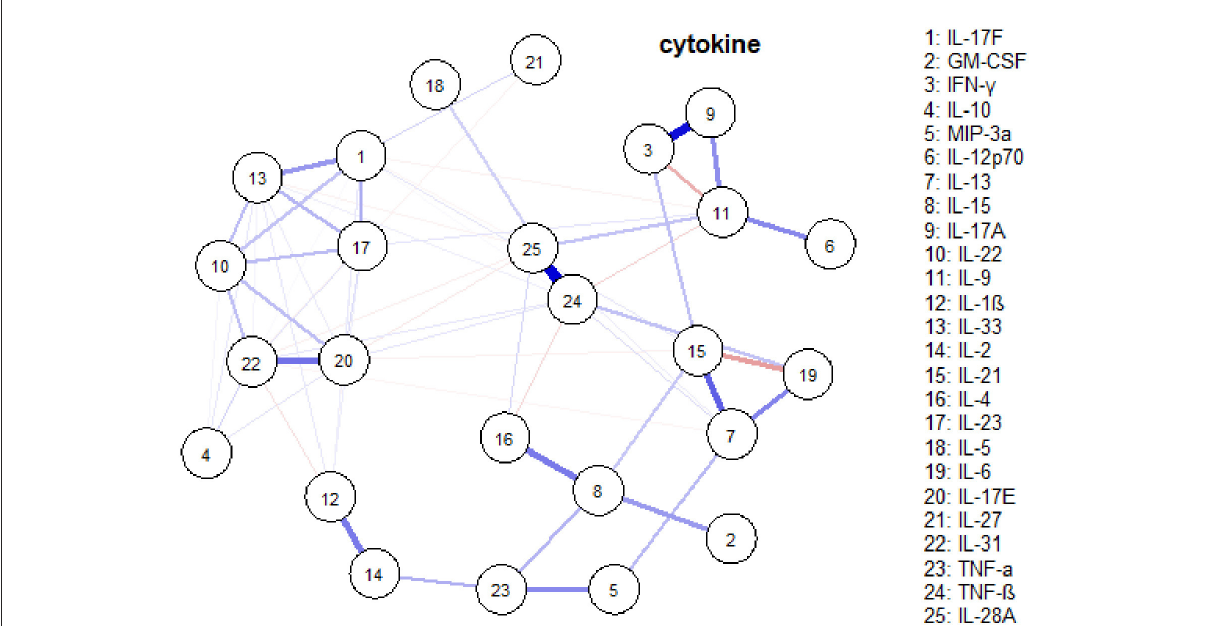
FIGURE5 An estimated network structure of serum cytokines. The weight edges represent the strength of connections, while the blue (red) edges stand for positive (negative) relationships.